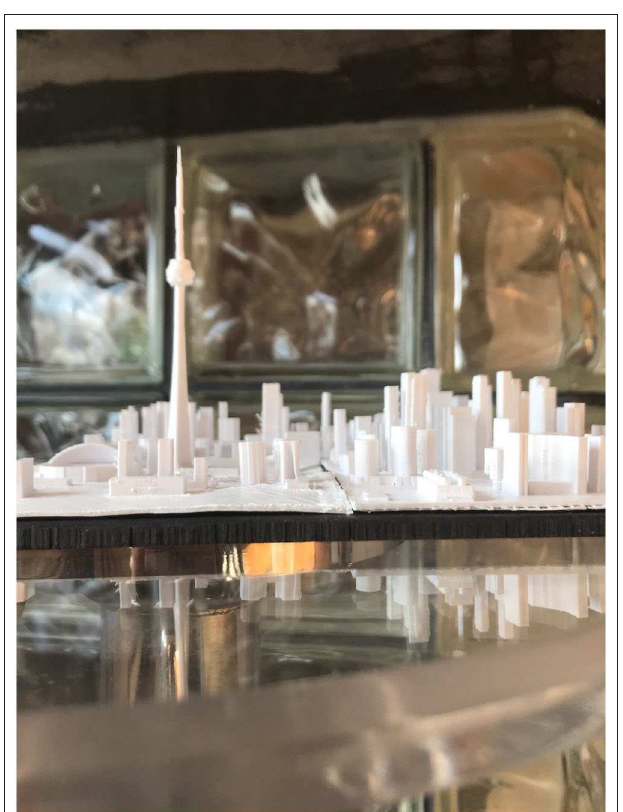
FIGURE 14 | Toronto